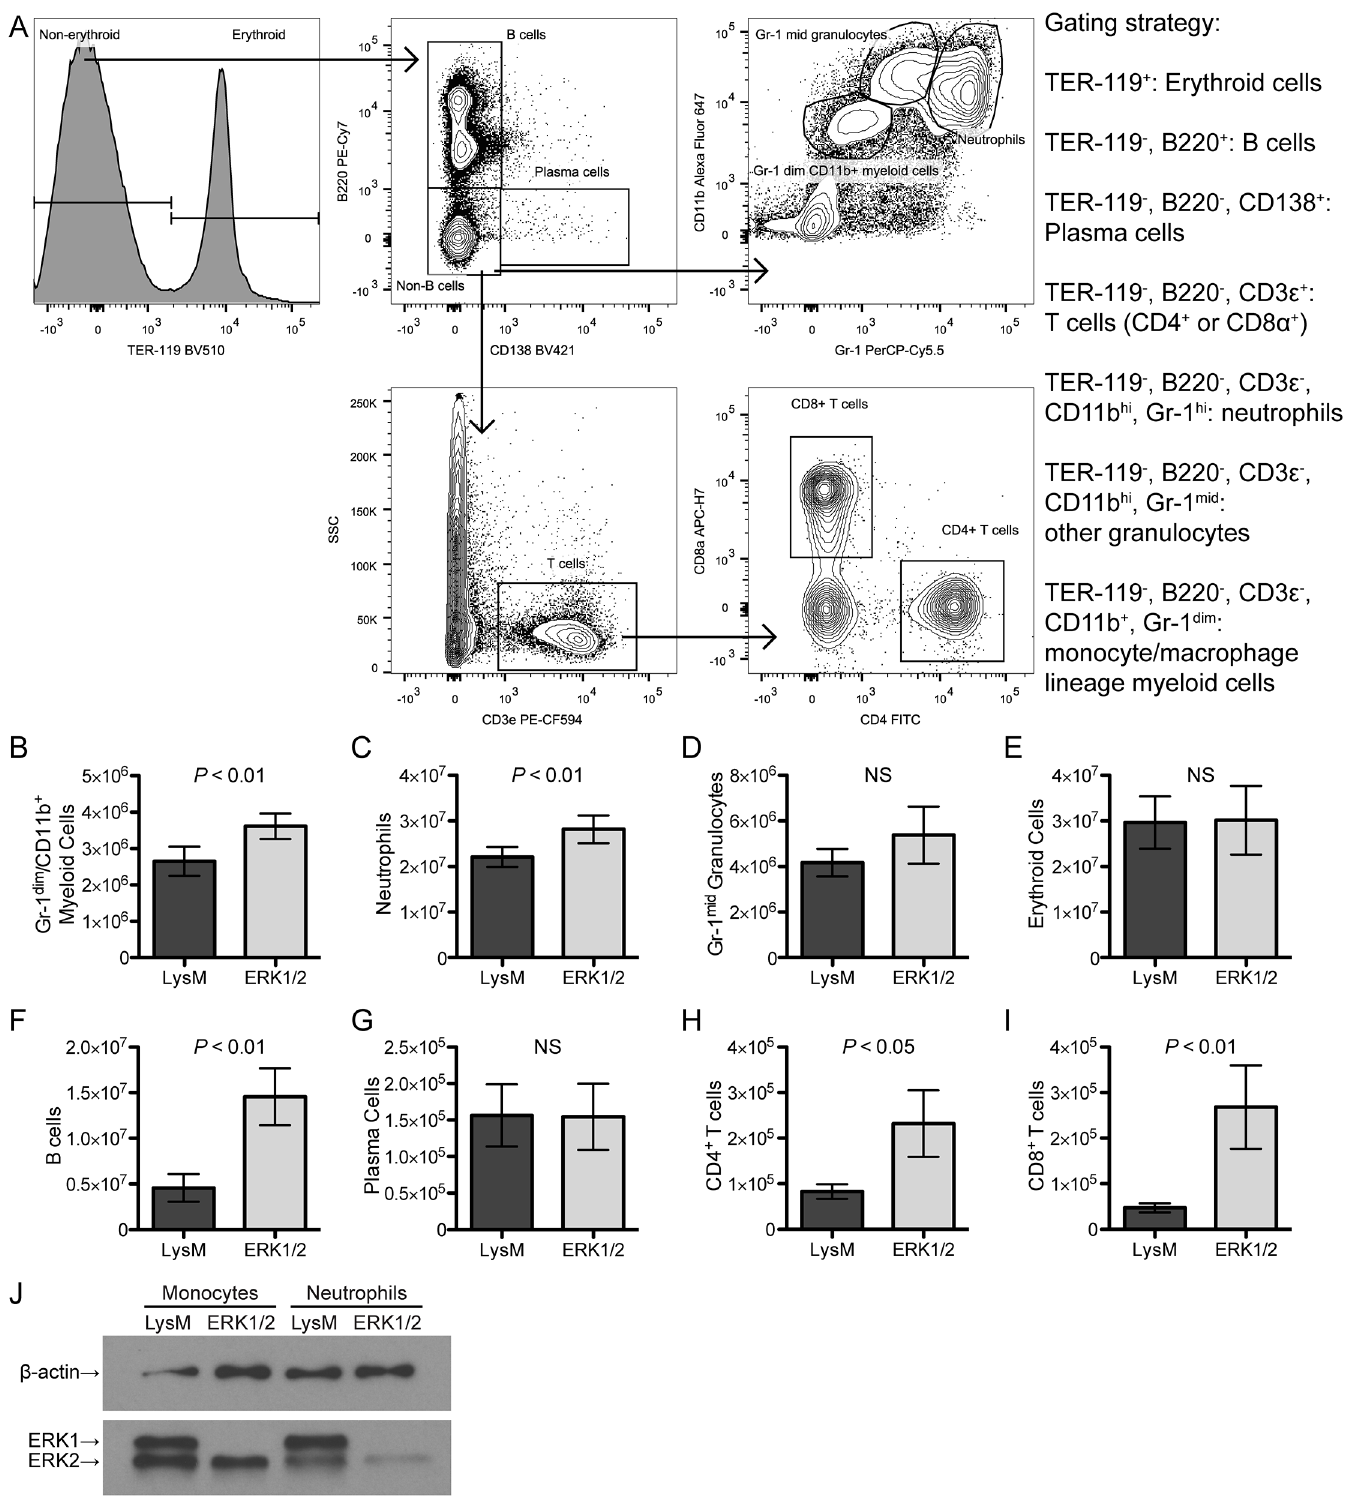
Fig 6. Bone marrow of ERK1/2 mice contains increased numbers of mature myeloid and lymphoid cells with retention of ERK2 expression in monocytes but not granulocytes. (A) Bone marrow cells from LysM and ERK1/2 mice (six of each) were analyzed by ex vivo flow cytometry to assess lineage-committed cells. (B-I) Cell numbers were calculated from total bone marrow cell counts and the percentage of each population in the gate.